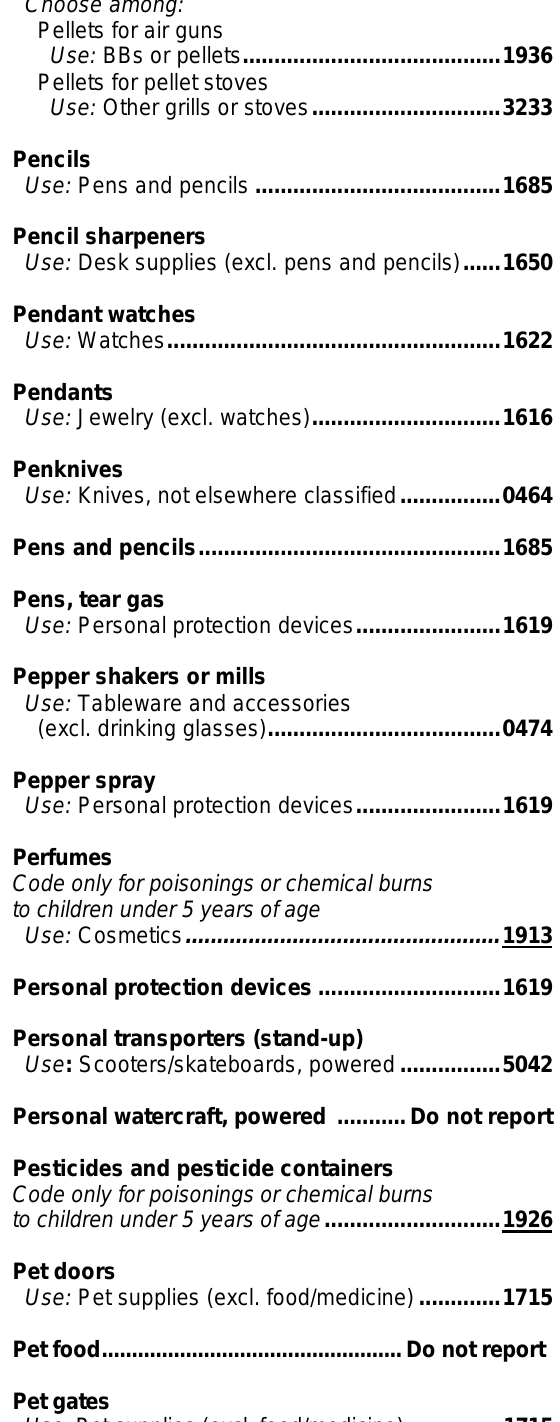
Pedestals Use: Tables (excl. baby changing tables, billiard or pool tables and television tables Peelers Use: Kitchen gadgets,